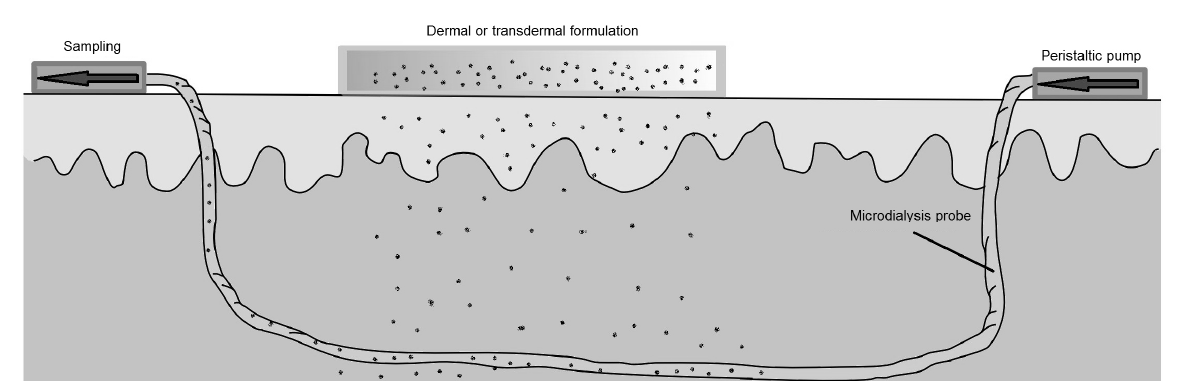
FIGURE 3 - Cutaneous